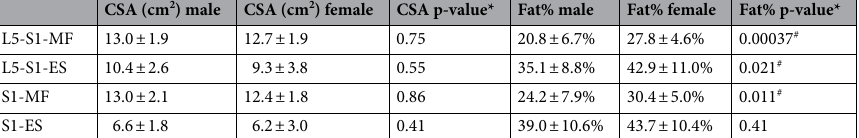
Table 2. Measurements (mean ± sd) of CSA and fatty infiltration (Fat%) of the multifidus (MF) and erector spinae (ES) with respect to sex. *The p -values were obtained with Spearman partial correlation while controlling for the effects of age and the side of pathology. Significant p -values are marked with “#”.